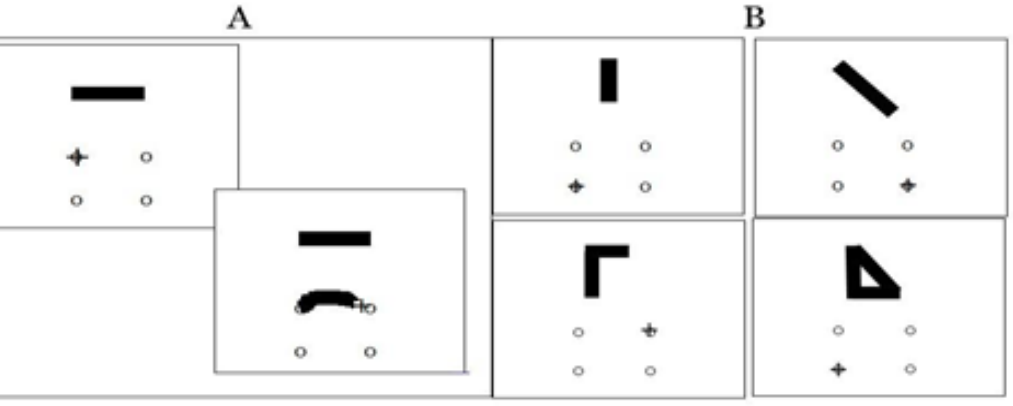
Figure 1 . Panel A: Schematic of a trial, showing the sample and a cursor start position (top), and a simulated correct response (bottom). Panel B: Four other sample stimuli and cursor start positions, including diagonal, two-line, and three-line probe